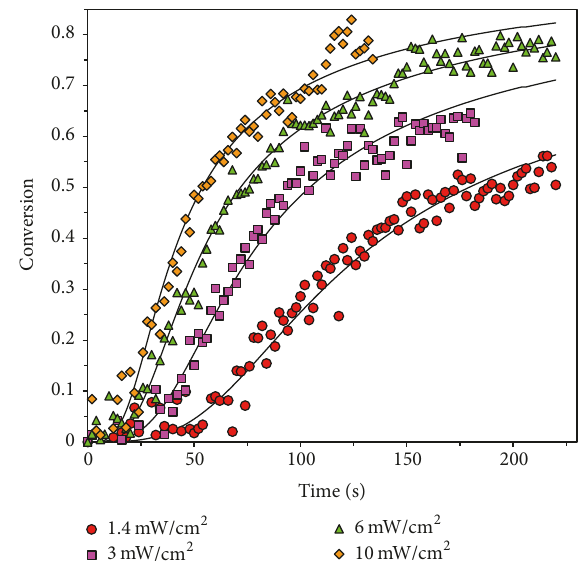
Figure 6: Comparison between the degree of conversion measured by Raman spectroscopy and that of calculated based on (3) at different light